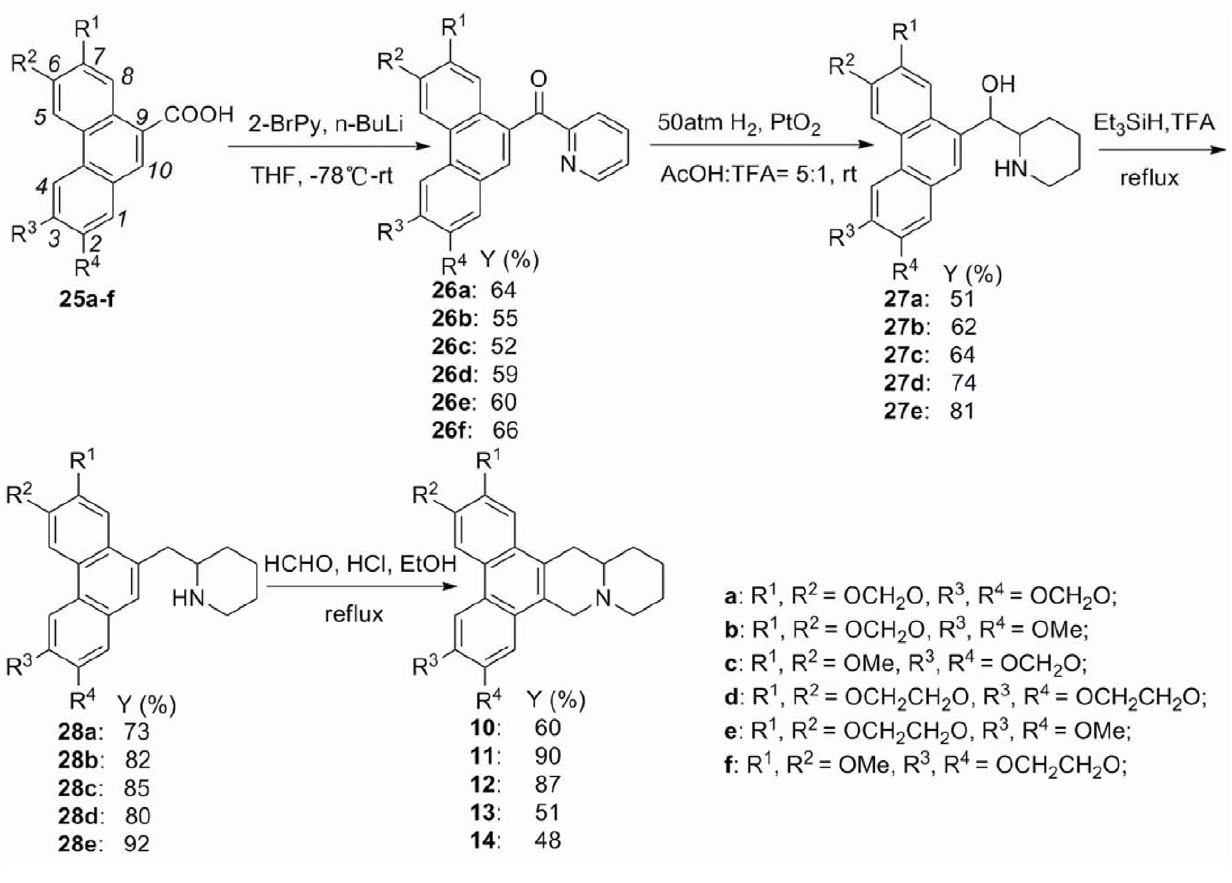
Figure 2. Synthesis of compounds 10–14.